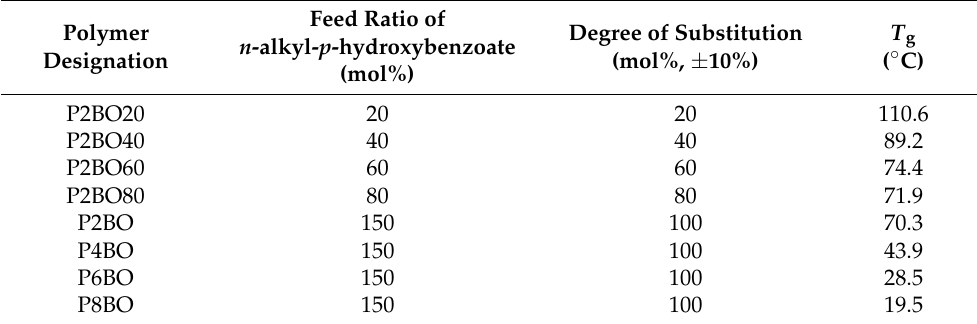
Table 1. Reaction conditions and results for the synthesis of the P2BO# and PABO (P2BO, P4BO, P6BO, and P8BO).